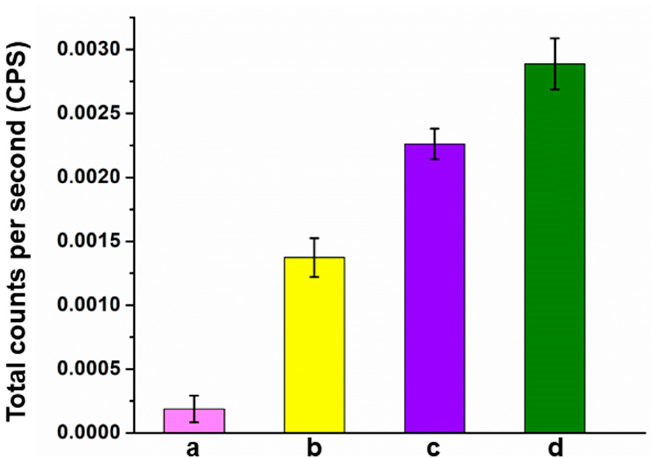
Figure 4. Total counts per second (CPS) of C 9 H 8 N + detected in a—OB, b—OB-POX, c—OB-POX/L- Trp d—OB-POX/D-Trp, using ToF-SIMS spectroscopy.